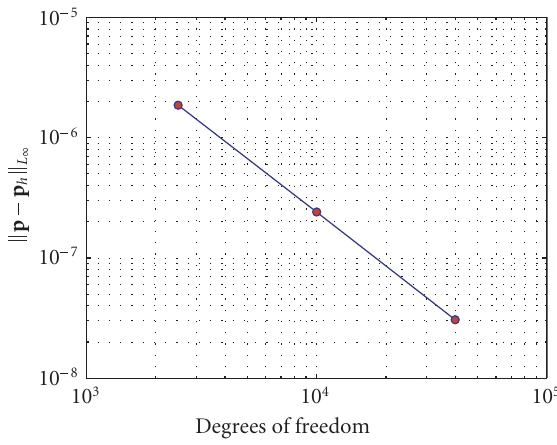
Figure 4.3 . Example 4.1: convergence of the discretization scheme. L ∞ error versus the degrees of freedom in the mesh. We are observing (cid:4) p − p h (cid:4) L edge in the mesh.